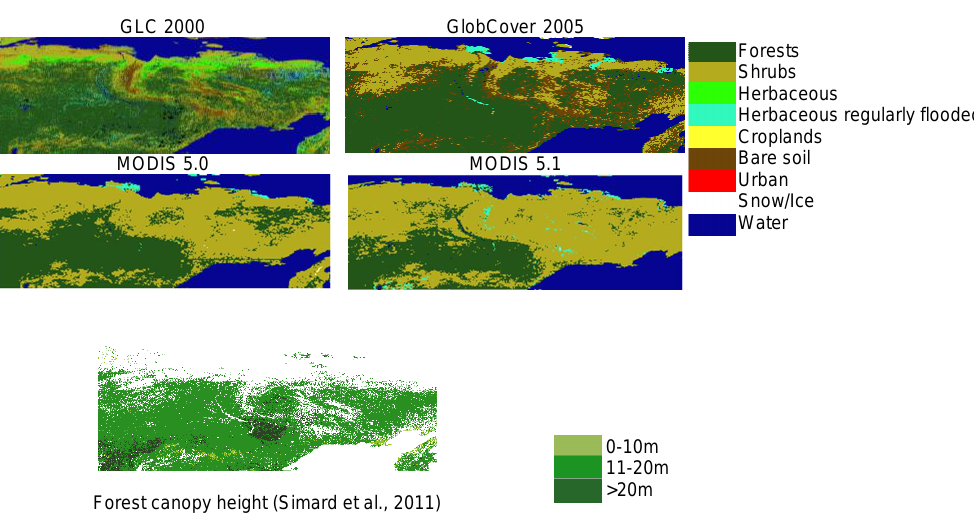
Figure 4. Comparison of four land cover products in Yakutia: GLC2000, GlobCover 2005, MODIS 5.0 and 5.1 for 2001, with the forest canopy height product provided by Simard et al. (2011). The forest classes were grouped together at 1km